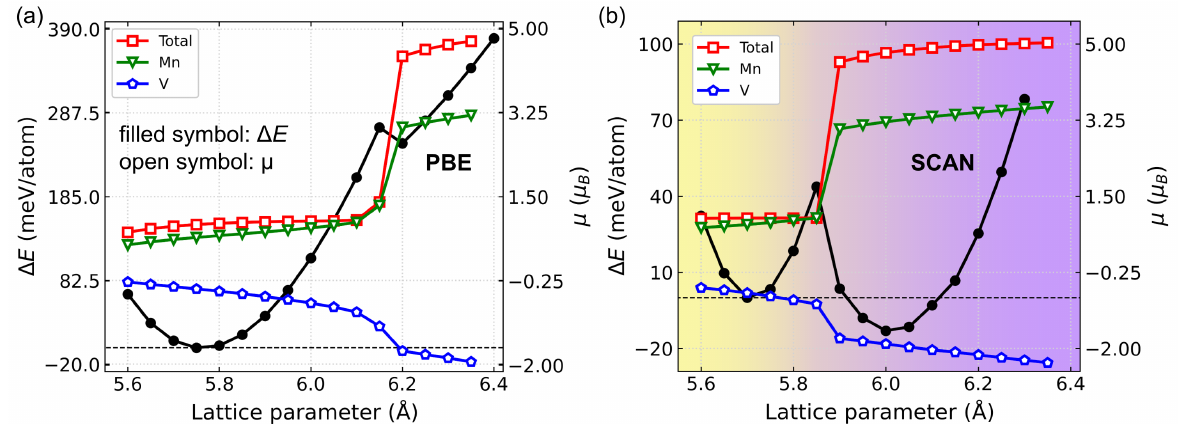
Figure 16. The total energy E and total and partial magnetic moments of Mn 2 VGe as a function of the lattice parameter for the ( a ) GGA and ( b ) SCAN solutions [137]. The E zero is fixed to the LMS energy minimum in all